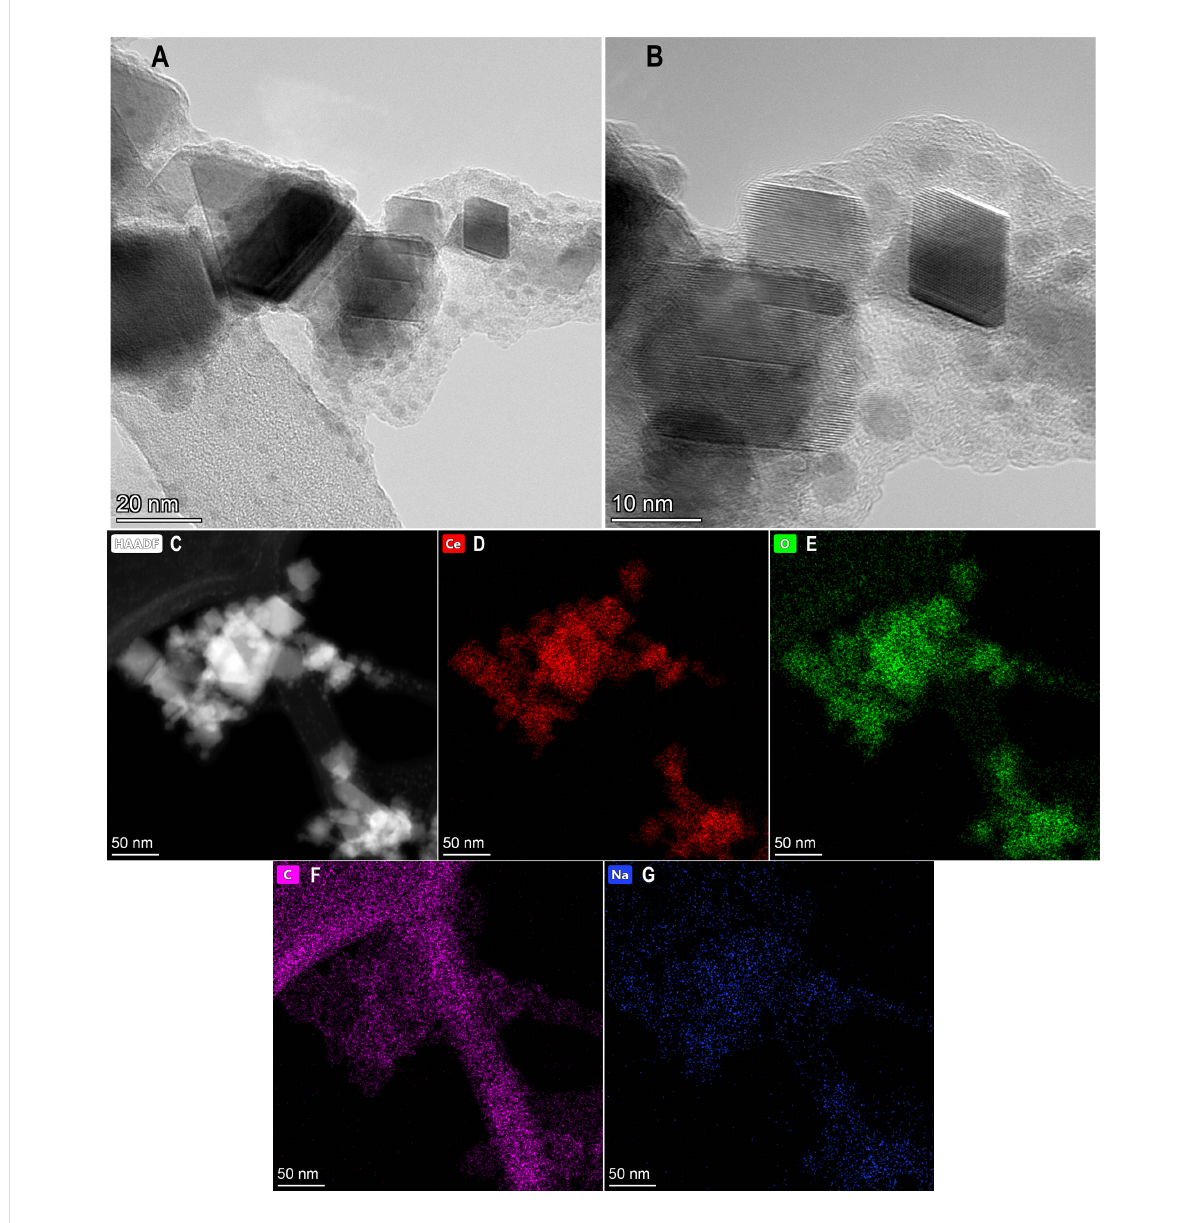
Figure 1: Transmission electron microscopy and high-angle annular dark-field scanning transmission electron microscopy images of NM-212 and its chemical composition determined by energy-dispersive X-ray spectroscopy. (A, B) TEM images, (B) is a part of (A) at higher magnification. (C) HAADF STEM image. (D–G) EDS-determined chemical composition.